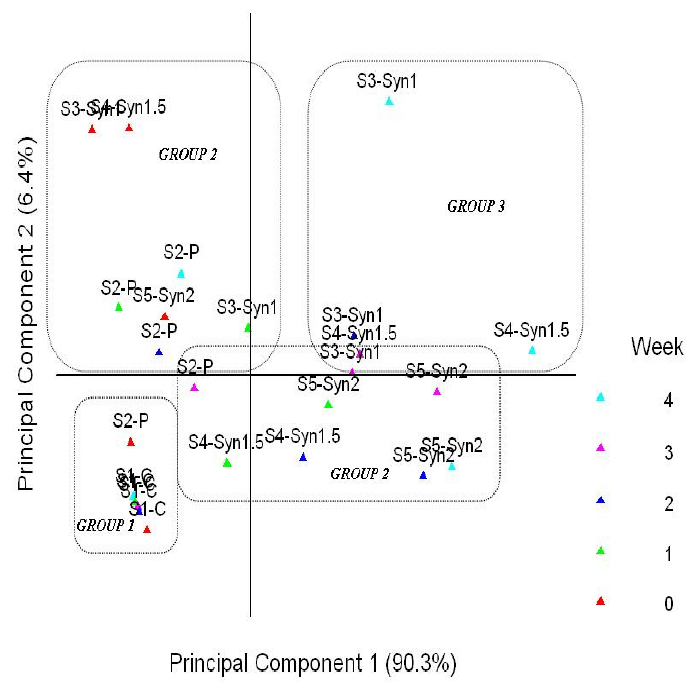
Figure 2. Principal component analysis of different yogurt samples on the basis of volatiles produced during storage of four weeks.